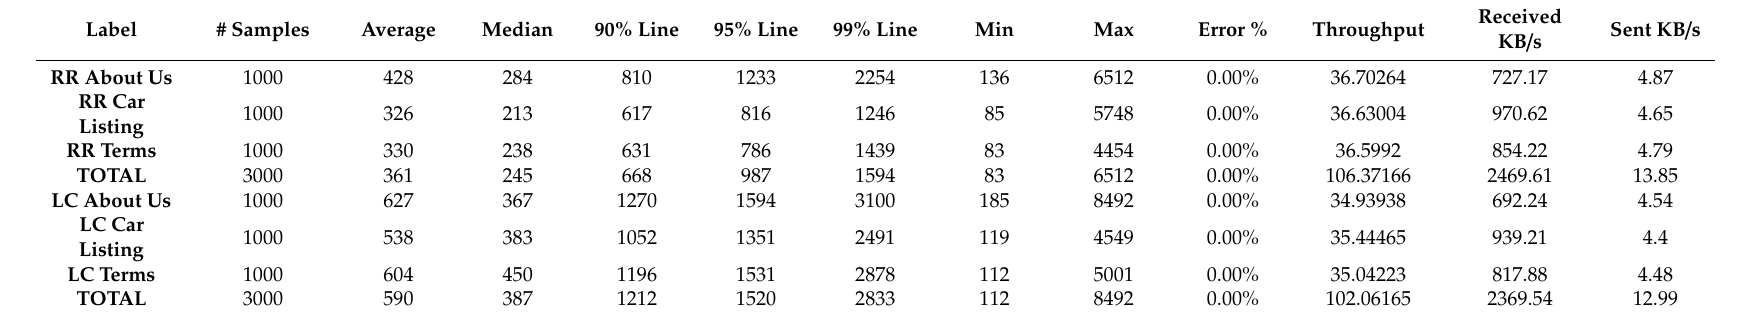
Table 5. Statistics table of the round robin algorithm and least connection algorithm of the second load